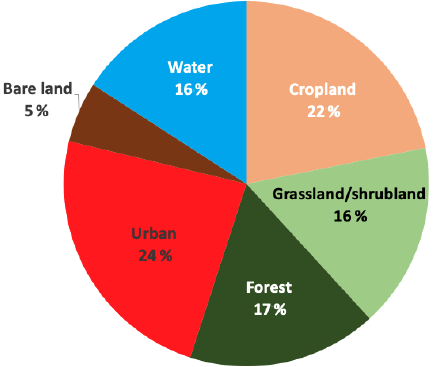
Figure 2. Representativeness of land surface types around the se- lected AERONET sites for the entire selected